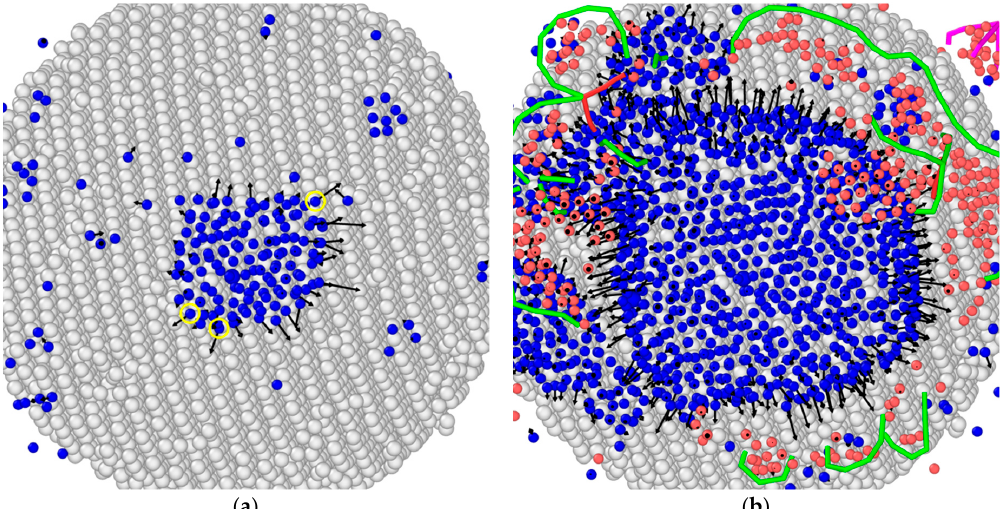
Figure 3. Snapshots from the same simulation as Figure 2 showing atomic displacements (black arrows) associated with ( a ) lattice-trapped delamination over an 18 ps time window and ( b ) dislocation-mediated delamination during a 2 ps time window. Blue atoms are associated with a crack (have an atomic volume > 30 Å 3 ). Green lines are Shockley-Read partial dislocations. Red atoms are associated with stacking faults. Yellow circles denote atoms whose atomic trajectories differ significantly from their immediate neighbors.